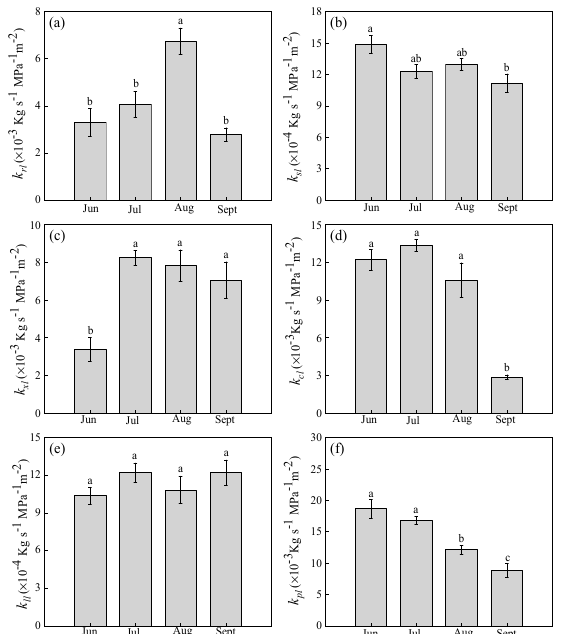
Figure 6. Seasonal changes in leaf-specific conductance (LSC) of ( a ) whole-roots ( k rl ), ( b ) whole-shoots ( k sl ), ( c ) one-year shoots ( k xl ), ( d ) current-year shoots ( k cl ), ( e ) leaf blades ( k ll ), and ( f ) petioles ( k pl ). Lower-case letters denote significance levels based on ANOVA post hoc means using LSD analysis ( p < 0.05). Data are means with standard error.